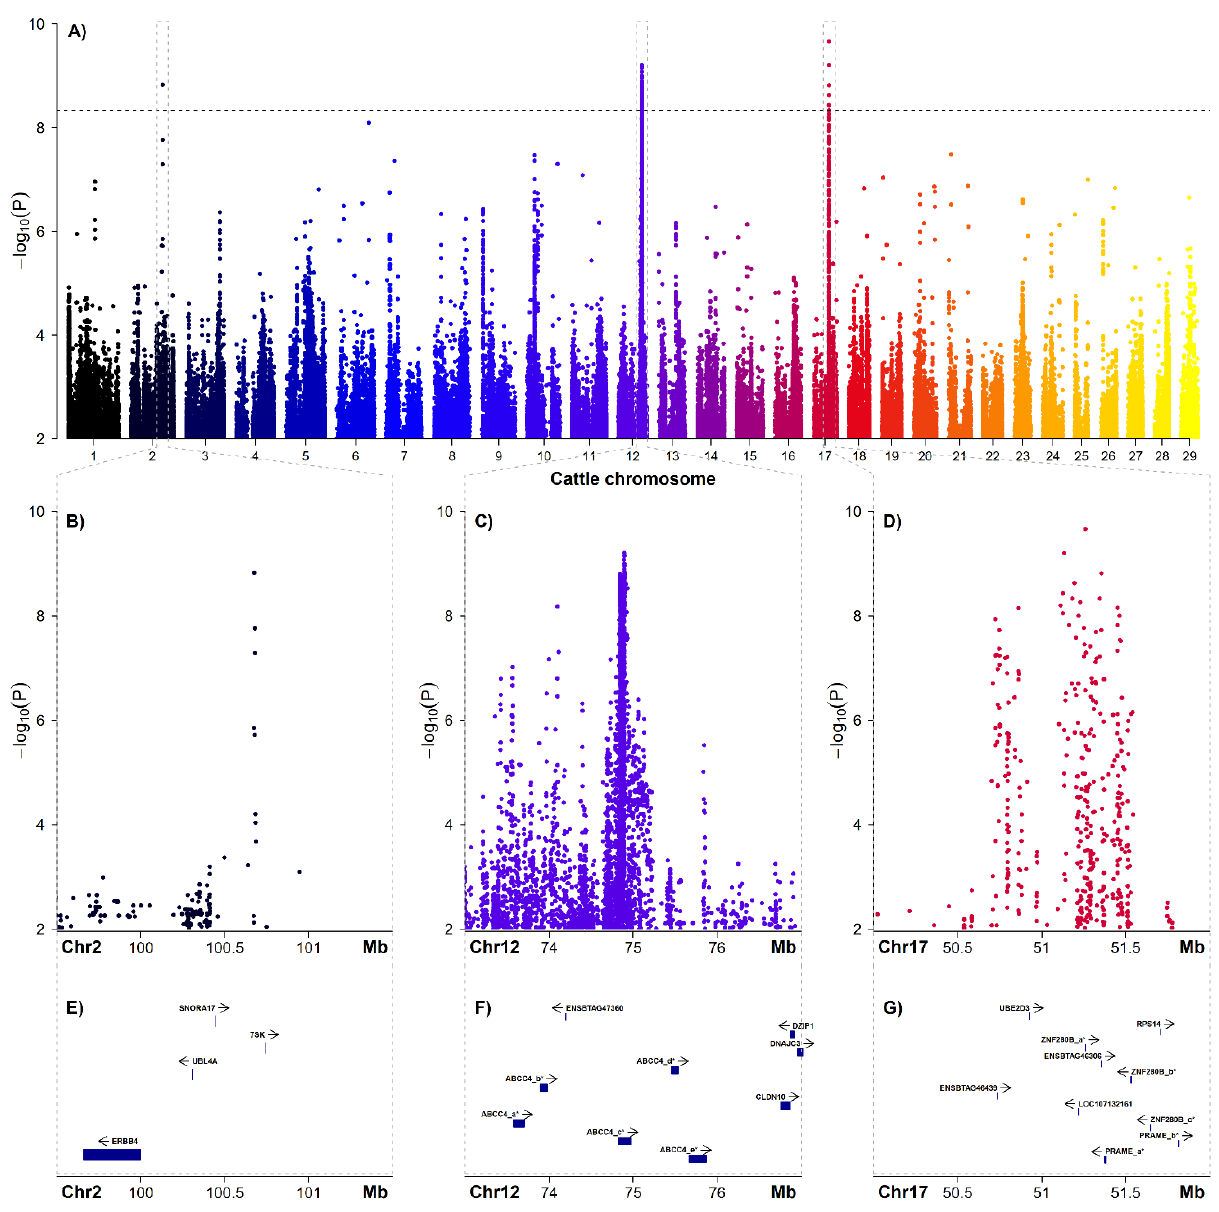
Figure 3. Results of the GWAS for BCSE in Holstein cattle based on imputed sequence level genotypes. ( A ) Genome-wide Manhattan plot of the GWAS results depicting the negative decadic logarithms of the p -values with respect to genomic position (UMD3.1). The horizontal dashed line represents the genome-wide significance threshold according to Bonferroni correction (pBonf < 0.05). Zoom into the three genome-wide significantly associated genome regions on chromosomes (Chr) 2 ( B ), 12 ( C ) and 17 ( D ). Gene content of the three BCSE-associated genome regions on Chr 2 ( E ), 12 ( F ) and 17 ( G ) according to Ensembl release 94 (UMD3.1, https://oct2018.archive.ensembl.org/Bos_taurus/Info/Index, accessed on 1 October 2020). Where no cattle gene symbols were available, human orthologue information was used or otherwise only the Ensembl ID is given. Note that genes marked with an asterisk and a subsequent letter do represent multiple genes annotated in the cattle genome with the same human orthologue. For further details, see Supplementary Material 2. Table 1. Top 20 of the genome-wide significantly associated variants (P Bonf ≤ 0.05). Bold lines indicate associations with P Bonf ≤ 0.01.